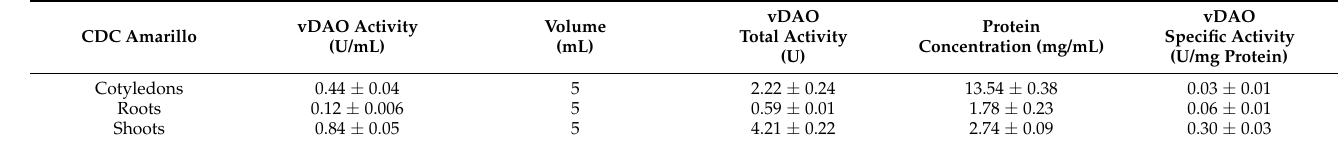
Table 3. vDAO activity in different organs of the pea variety CDC Amarillo after 5 days of germination.